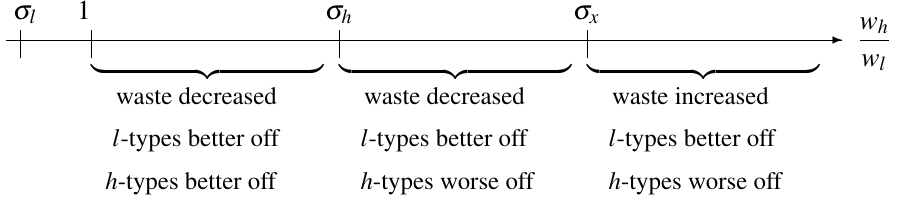
Figure 1: The effects of a marginal increase in τ as a function of w h / w l